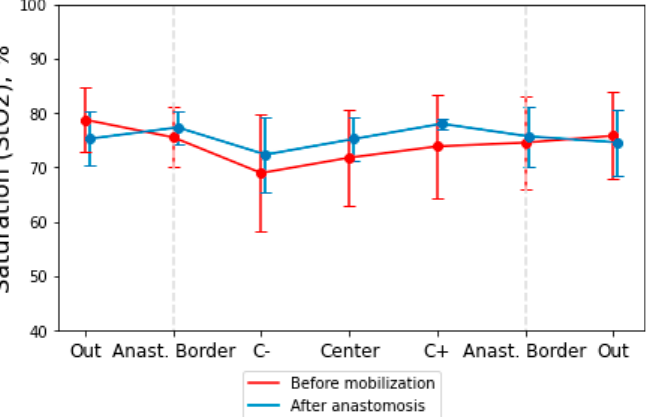
Figure 5. Dependence of intestinal StO 2 before mobilization and after anastomosis. The dotted lines mark the boundaries of the anastomosis. “Center” point is the center of zone of mobilization in the “Before mobilization” stage. In the “After anastomosis” stage, this point is the anastomosis suture position. “C+” and “C − ” points are positioned higher and lower on the bowel from the center of the mobilization